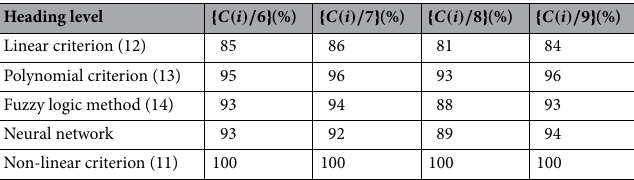
Table 5. The results of the diagnostics of cardiovascular diseases { C ( i )/ k } , k = 6, 9 (% of correct diagnoses).